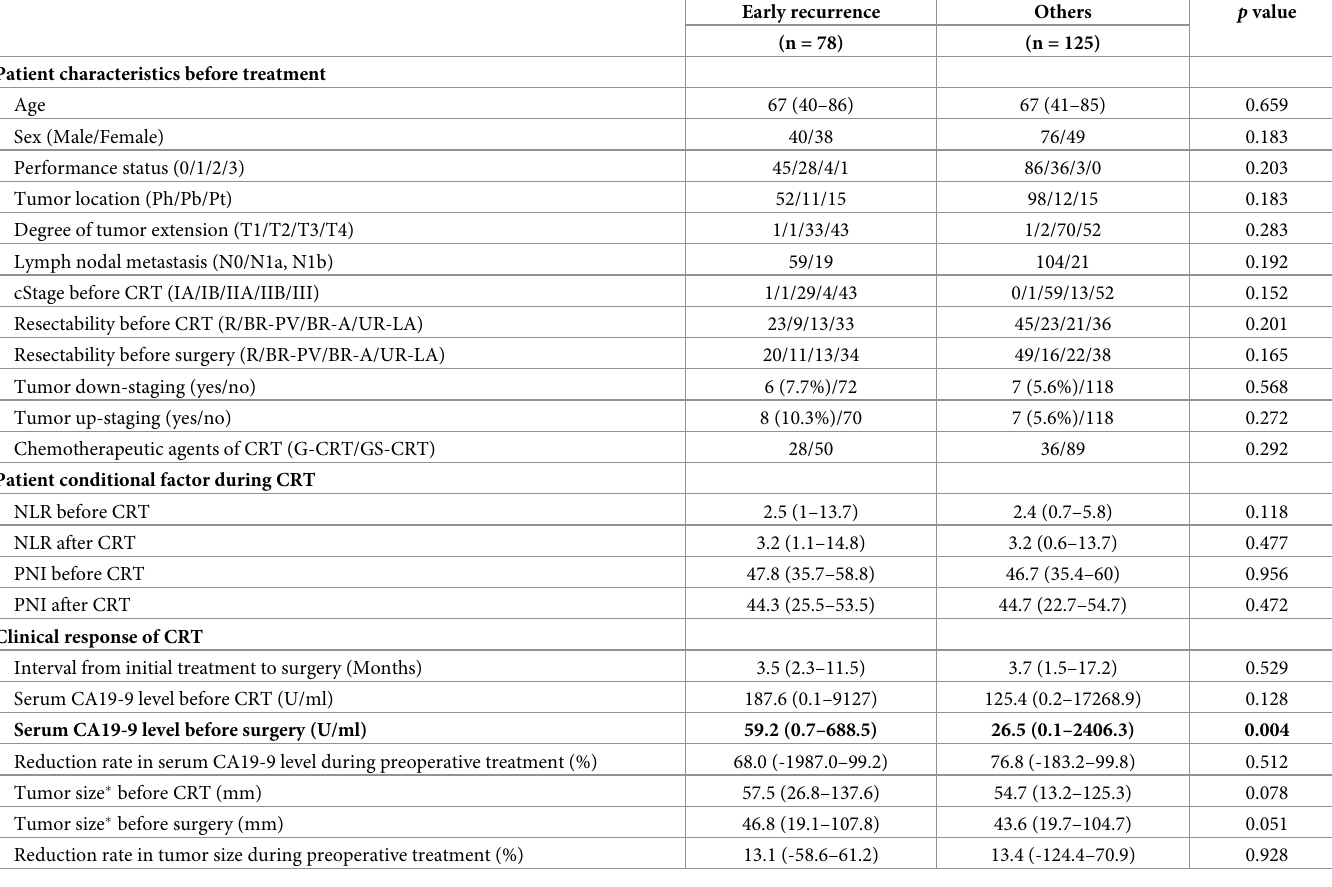
Table 2. Patient characteristics and clinical response of preoperative chemoradiotherapy in the localized pancreatic cancer patients with curative-intent resection according to the occurrence of early recurrence after